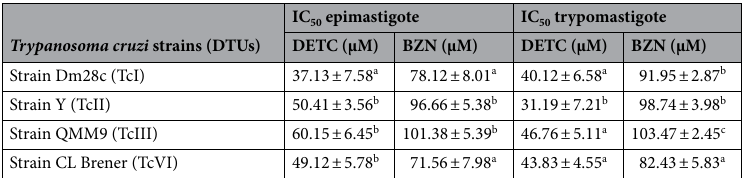
Table 1. DETC antiparasitic activity, expressed in IC 50 values ± standard deviation, against the different strains and forms of Trypanosoma cruzi after 24 h of exposure, based on results expressed by couting essay. The statistical analysis the Anova Test together with the Tukey Post-test. The statistical analysis used measure the IC 50 value in each group under same conditions. BZN